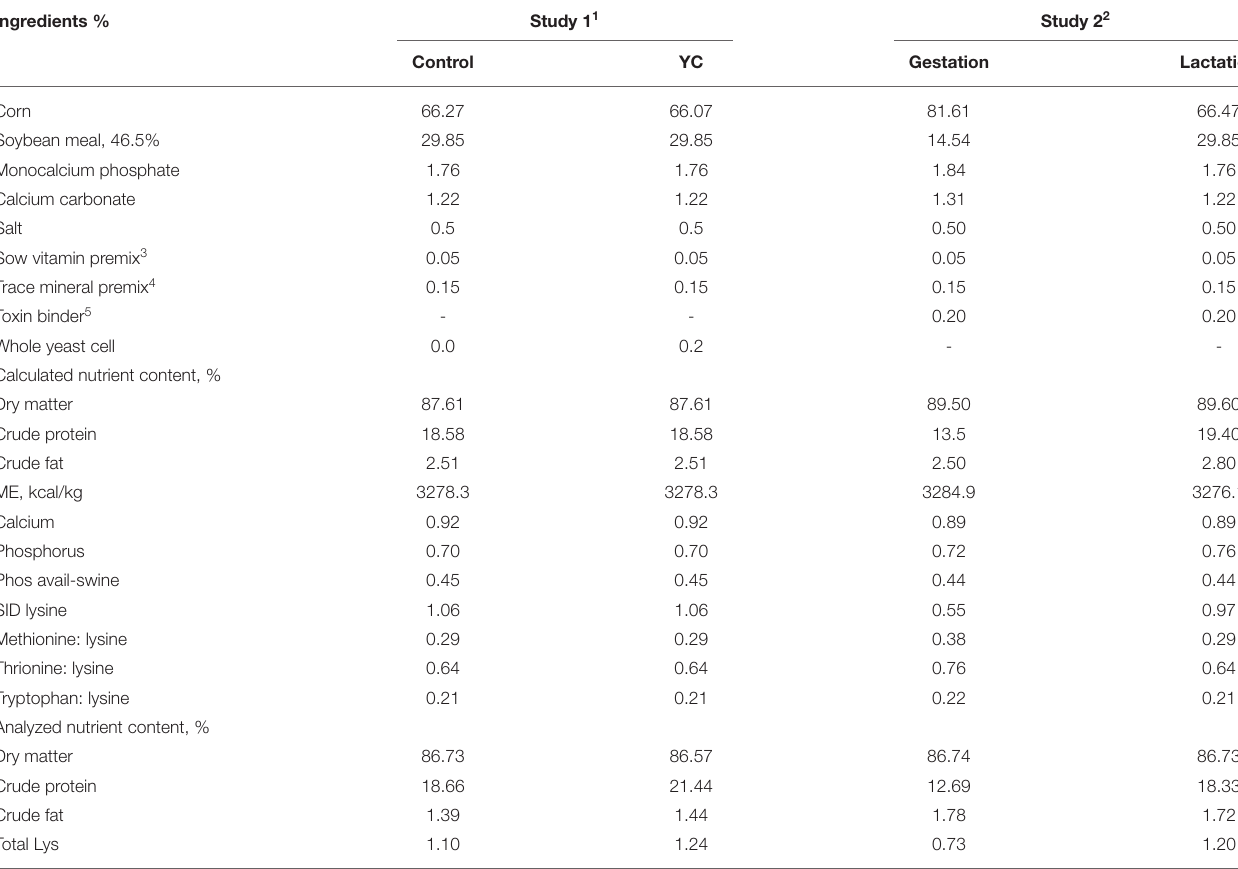
TABLE 1 | Ingredient composition and nutrient content of sow diets in studies 1 (lactation) and 2 (gestation/lactation). Ingredients